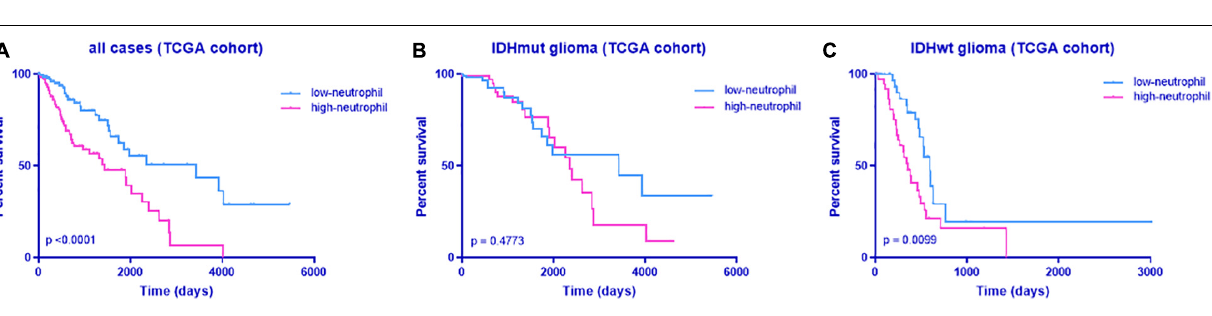
FIGURE 5 | Kaplan–Meier analyses of overall survival according to the neutrophil enrichment score from GSVA. (A) All cases, (B) all cases with IDH mutant, and (C) all cases with IDH wild-type. The discriminative power of TERT was assessed with the Kaplan–Meier plotting method and the log-rank test. Significant p <